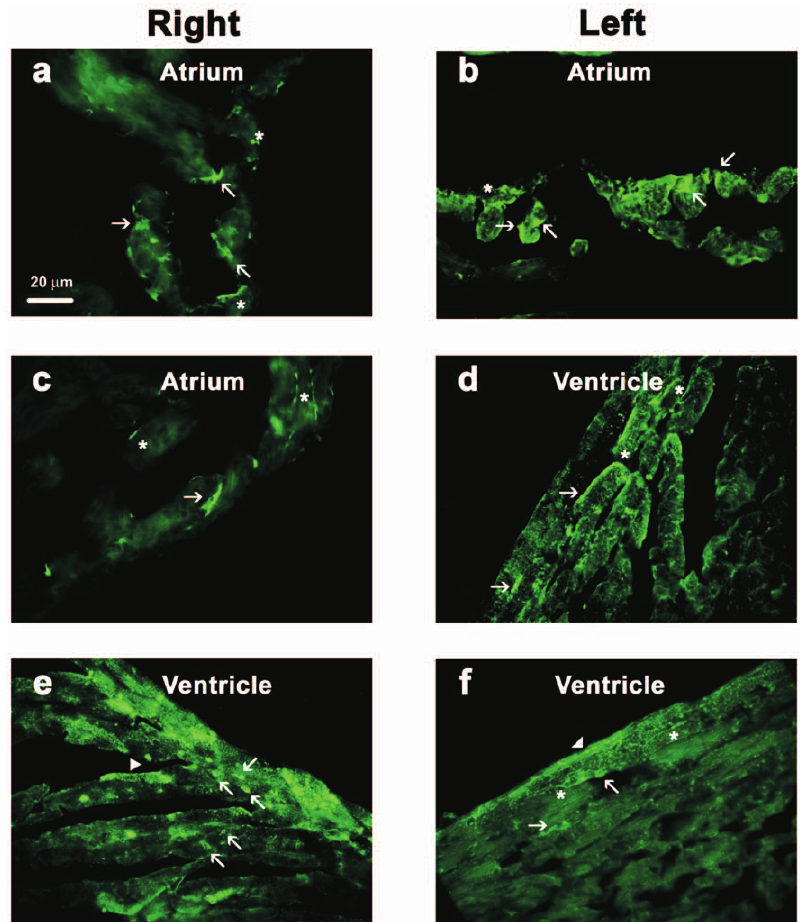
Figure 8. Pnmt is expressed in all chambers of the adult mouse heart. Immunofluorescent staining in the adult mouse heart using an anti- Pmnt antibody shows active expression in both right and left atria (a–c). The majority of fluorescently labeled cells (green) in the atria have a triangular-shaped appearance (arrows) with neuronal-like extensions (asterisks). In addition, cardiomyocyte-like cells also show positive Pmnt staining (arrowheads) which appears to be cytoplasmic while a few cells show staining along their lateral border (d–f). The ventricular myocardium also displayed small triangular-shaped cells which were positive for Pmnt expression (e, arrows).